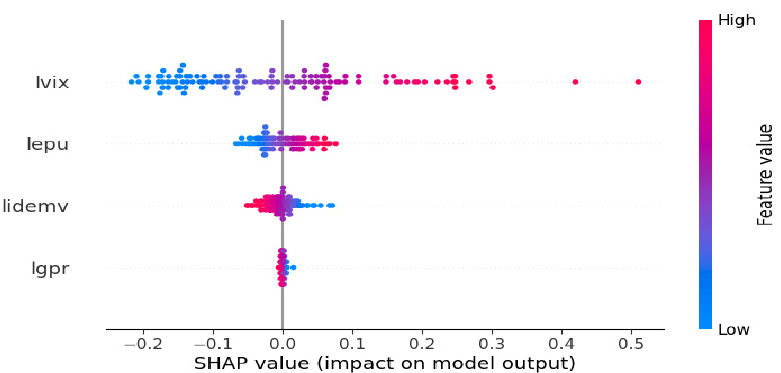
Figure 9. The SVM model: Feature importance during the pandemic (Daily frequency).